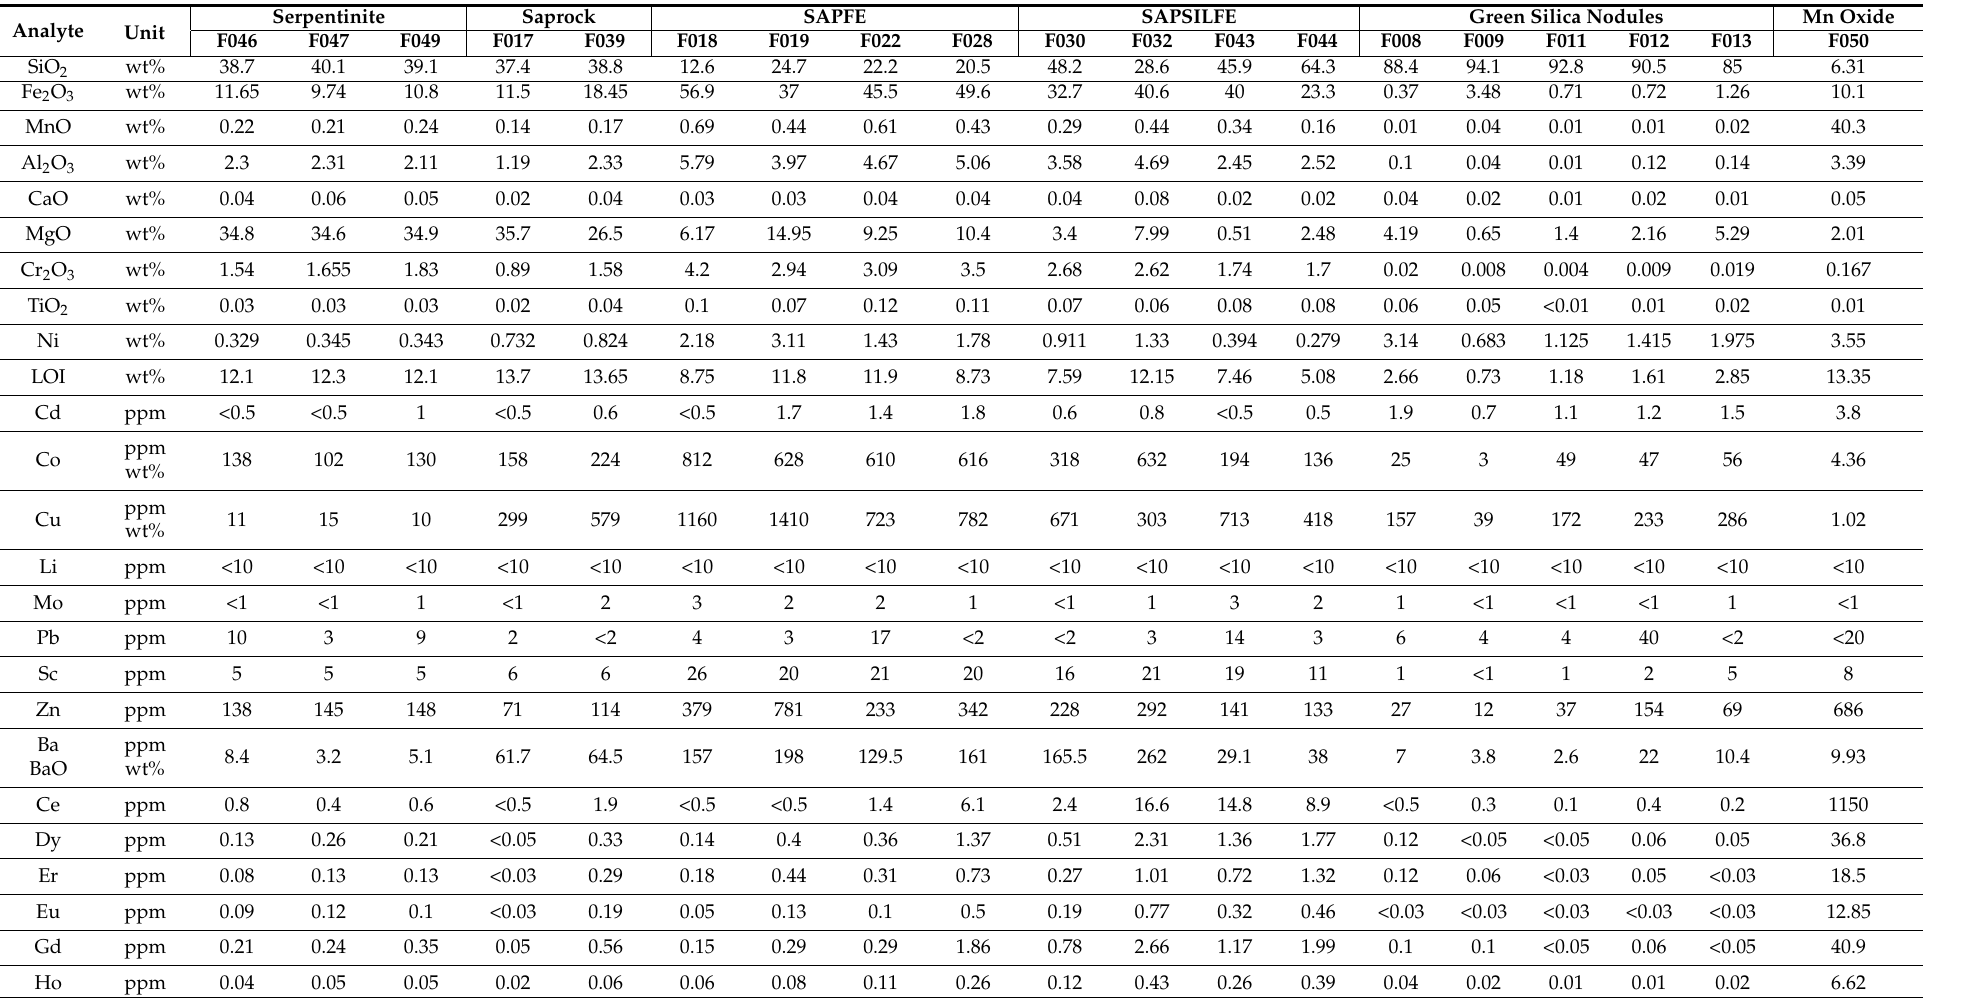
Table 1. Bulk chemical analyses of the Piau í laterite samples Serpentinite, Saprock, SAPFE, SAPSILFE, Green Silica Nodules and Mn-Oxide (Additional elements are presented in (Table S1 of the Supplementary